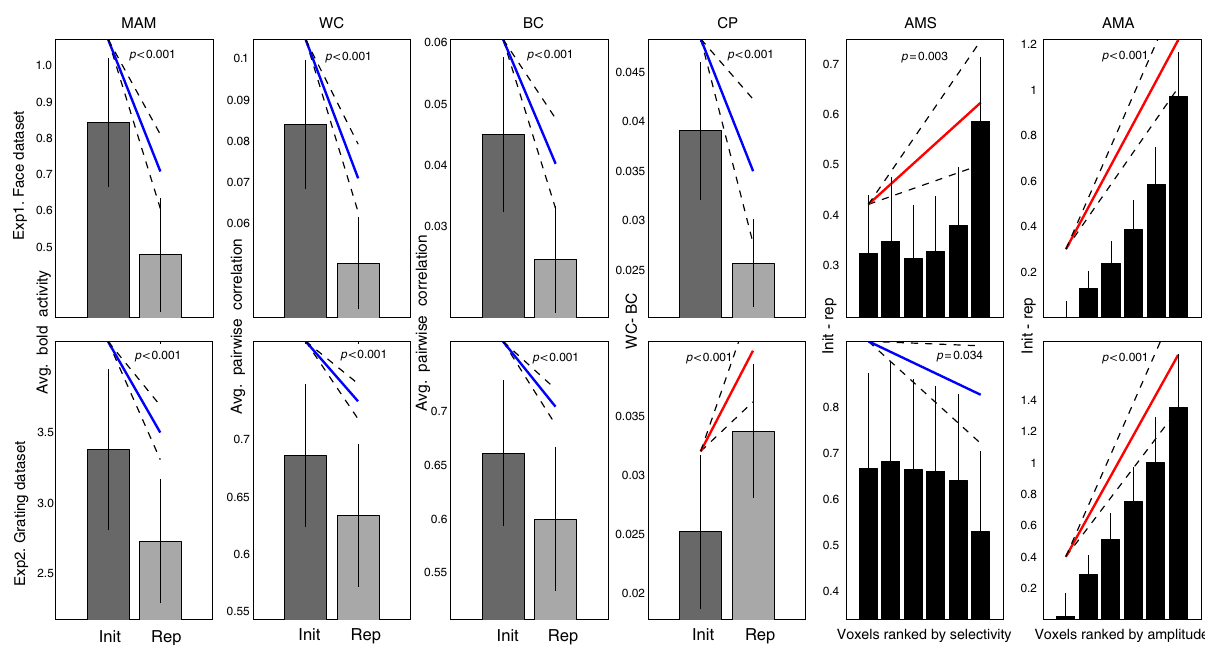
Fig. 3 The six data features (columns) for each paradigm (rows). Data features: Mean Amplitude Modulation (MAM), Within-class Correlation (WC), Between-class Correlation (BC), Classi fi cation Performance (CP), Amplitude Modulation by Selectivity (AMS) and Amplitude Modulation by Amplitude (AMA). Bars re fl ect mean of each condition (init initial presentation, rep repeated presentation), with error bars re fl ecting 95% con fi dence interval given between-participant variability; diagonal line represents slope of linear contrast across conditions (red = positive; blue = negative) with dashed error margins re fl ecting 95% con fi dence interval of that slope (equivalent to pairwise difference when only two